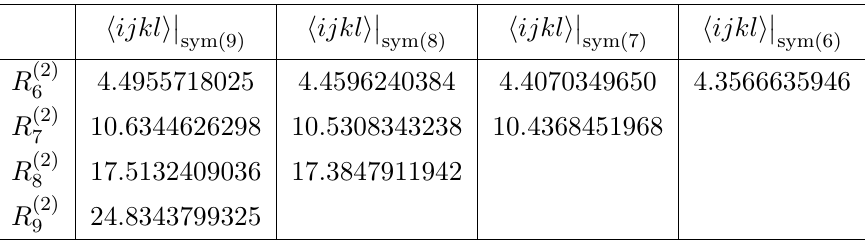
(cid:12) for (cid:12) sym ( n 0 )